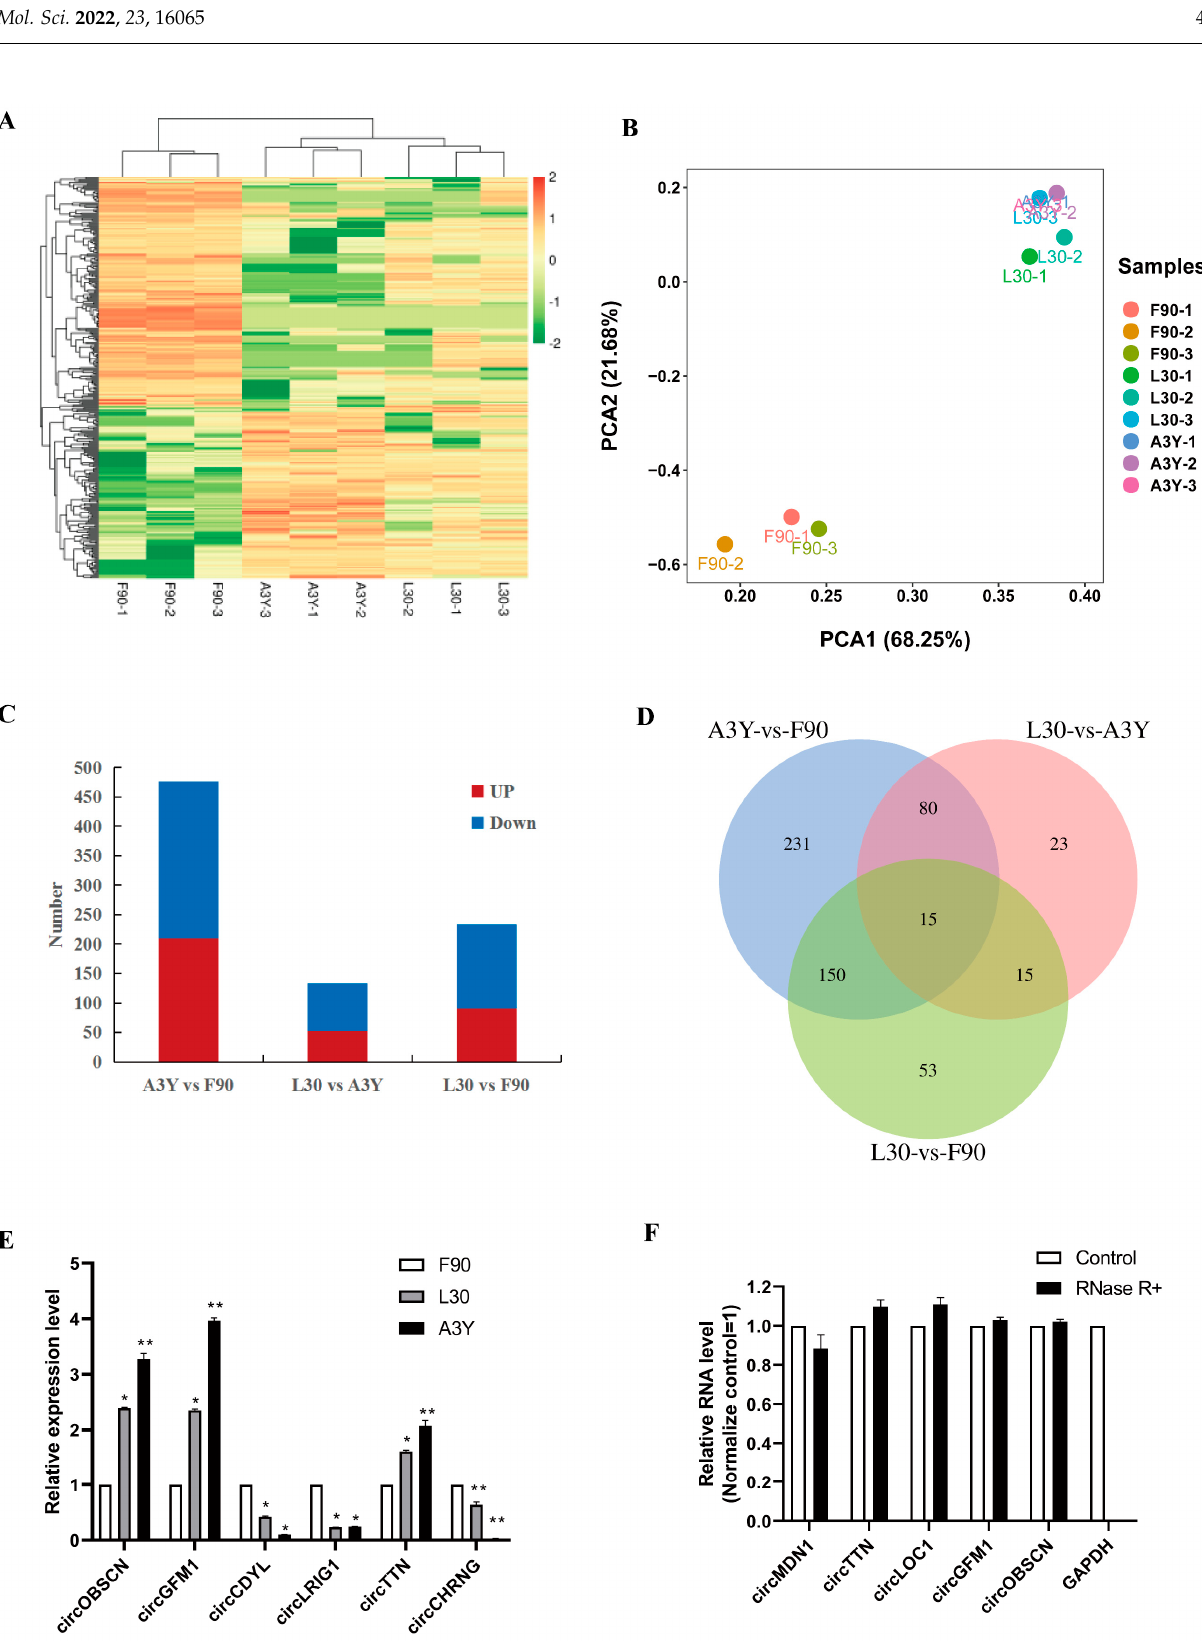
Figure 2. Analysis of differentially expressed circRNAs in sheep longissimus dorsi muscle. ( A ) Heatmap showing the expression dynamics of circRNAs in F90, L30, and A3Y. ( B ) PCA analysis. ( C ) DEcircRNA numbers. ( D ) DEcircRNA Venn diagram. ( E ) Validation of circRNA expression in sheep skeletal muscle by RT-qPCR. ( F ) Expression of circRNAs analyzed in RNA samples treated with both RNase R (–) and RNase R (+). We considered p < 0.05 to be statistically significant. * p < 0.05, ** p <